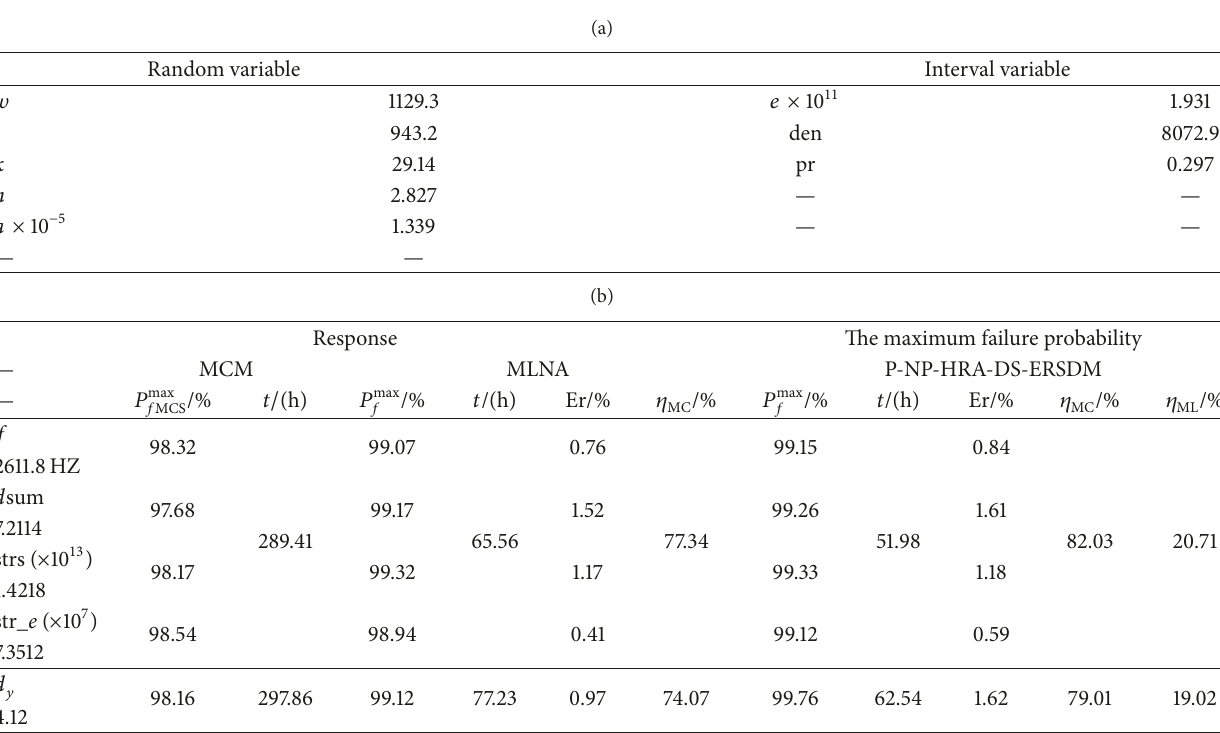
Table 2: Analysis results of modal and vibration response of P-NP-HRA-DS-ERSDM for the tuned